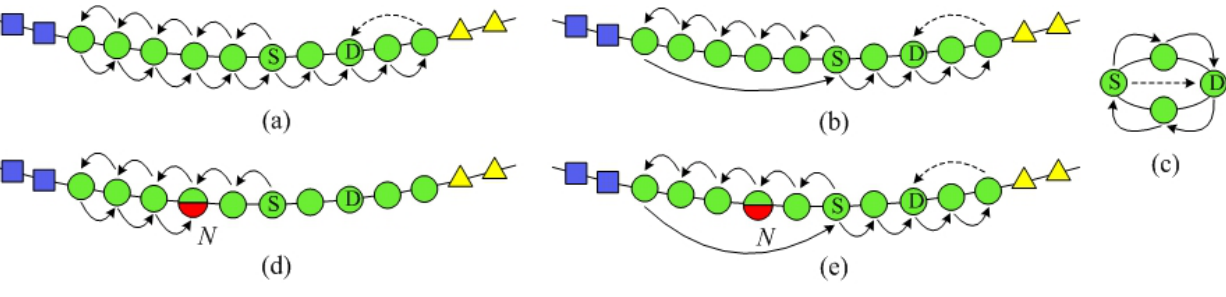
Figure 6. Node structure and message NumericID routing for SPEQ . ( a )